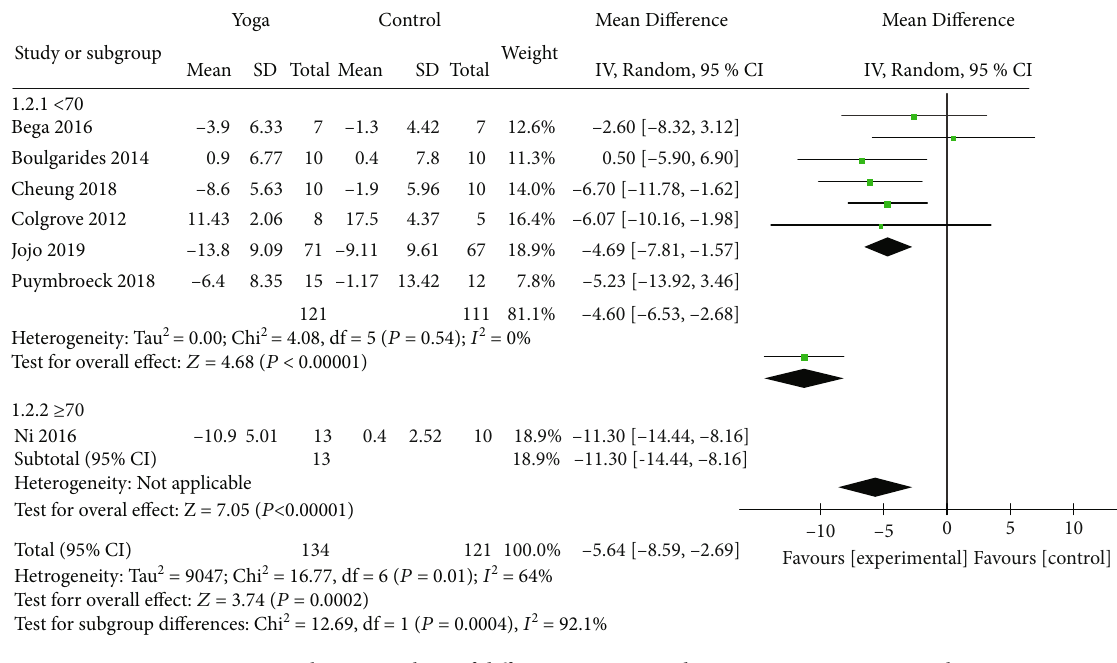
Figure 4: Subgroup analysis of di ff erences among studies in UPDRS-III rating results.